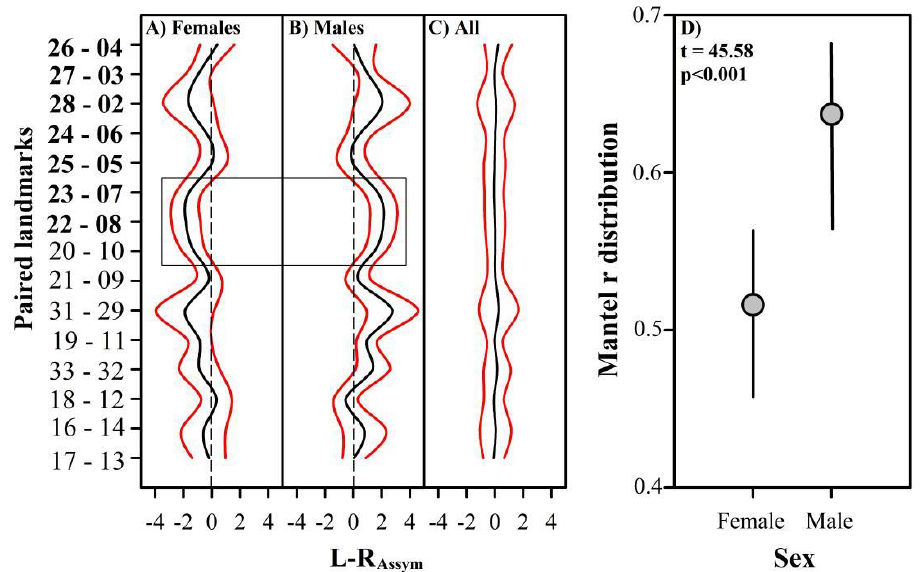
Figure 3. Longitudinal profiles of the directional asymmetry of females ( A ), males ( B ) and the fluctuating asymmetry ( C ) (mean ± 95% CI). Paired landmarks with and without bold represent the cephalic and thoracic modules, respectively. The box includes the paired landmarks that showed significant differences in the asymmetry of males and females. ( D ) Female – male comparison in the distributions of Mantel r obtained by correlating the asymmetric shape components of the developmental modules.